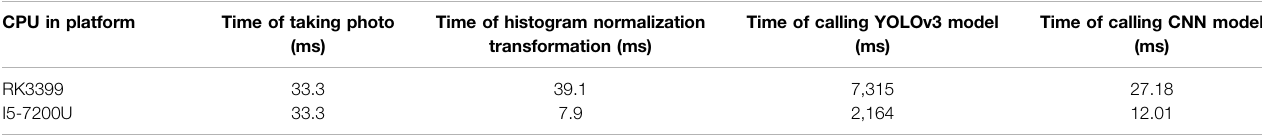
Frontiers in Physics |